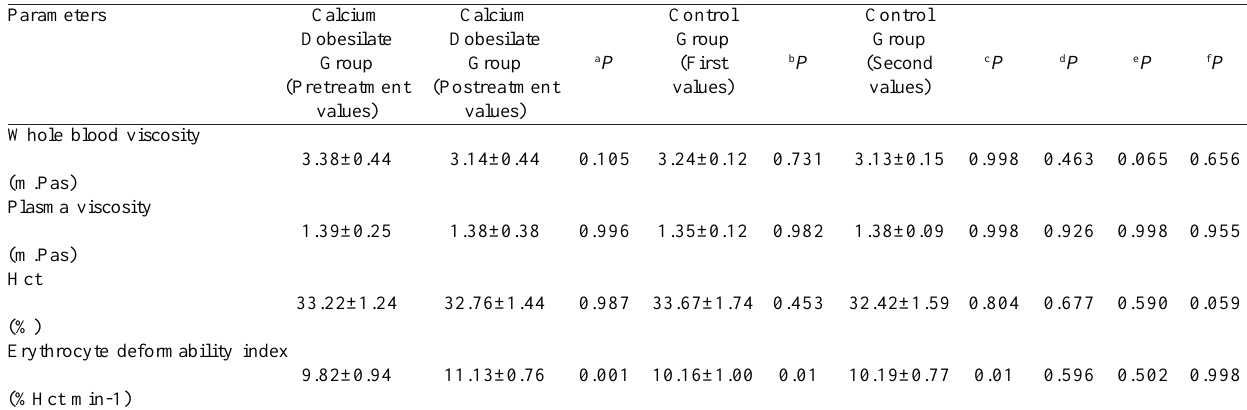
Table 2. BV, PV, Hct and EDI values before and after calcium dobesilate treatment in the calcium dobesilate group and first and second values after 3 months in the control